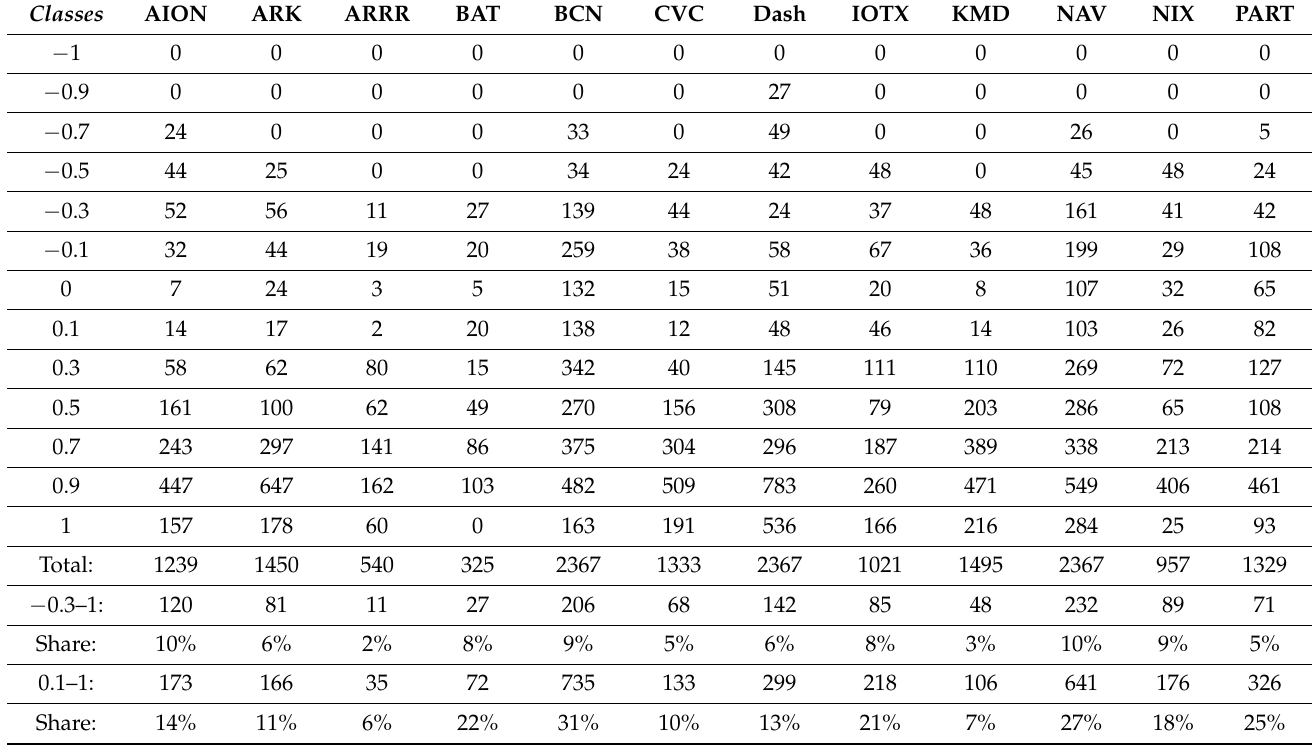
Figure 4. Price development in USD of Bitcoin, BTC (right-side y -axis) and Partcl, PART (left-side y -axis) since 1 January 2019. Table 5. Rolling 100 days correlation distribution in different correlation classes (0.2 correlation is below p value of 0.05, and 0.26 is below p value of